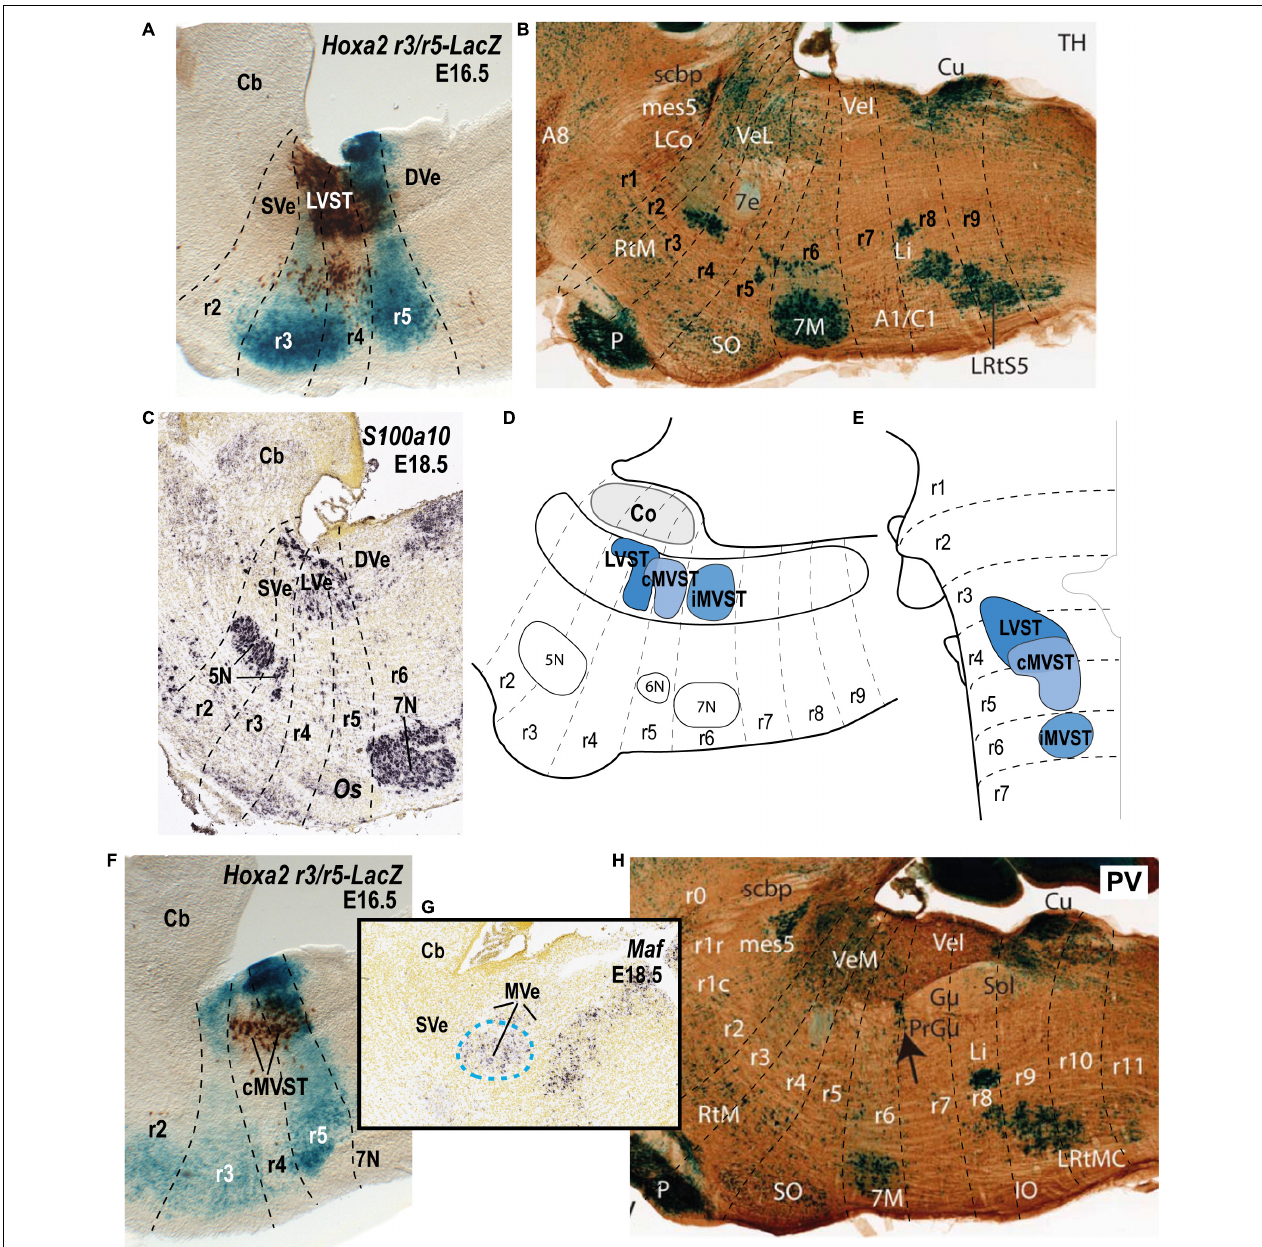
FIGURE 4 | Relationship of the vestibulospinal neuron groups to the rhombomeres in the mouse. (A) Lateral sagittal section illustrating retrograde biotin-conjugated dextran amine (BDA) labeling of the lateral vestibulospinal group (LVST) relative to the r3 and r5 domains in a r3/r5:lacZ transgenic mouse at E16.5 (see Pasqualetti et al., 2007). (B) Sagittal section of an adult AZIN1-lacZ mouse counterstained with antibodies to tyrosine hydroxylase (TH). Note the weak lacZ signal in the lateral vestibular nucleus (VeL), and the stronger lacZ signal in the mesencephalic trigeminal nucleus (mes5). Other recognizable characteristic landmarks are labeled [modified from Martinez-de-la-Torre et al. (2018); their Figure 1C ]. (C) S100a10 expression predominantly in the lateral vestibular nucleus (LVe; blue dashed line) in a sagittal section downloaded from the Allen Developing Mouse Brain Atlas (experiment 100055828; image 9 of 18). (D,E) Schematic comparison of the vestibulospinal neuron groups according to fate map reported by Pasqualetti et al. (2007). (F) Medial sagittal section showing retrograde BDA labeling of the contralateral medial vestibulospinal tract group (cMVST) in the r3/r5:lacZ transgenic mouse at E16.5 (Pasqualetti et al., 2007). (G) Expression of Maf at E18.5 (experiment 100132196; image 10 of 20: Allen Developing Mouse Brain Atlas). Note that Maf -positive cells in the rostralmost part of the medial vestibular nucleus (MVe, blue dashed line), have a location identical to that of the cMVST (compare to F) . (H) Sagittal section of an adult AZIN1-lacZ mouse counterstained with antibodies to parvalbumin (PV) showing lacZ expression in the medial vestibular nucleus (VeM). By contrast, the inferior (descending) vestibular nucleus (VeI) lacks lacZ signal [modified from Martinez-de-la-Torre et al. (2018); their Figure 2A ]. 5N, motor trigeminal nucleus; 6N, abducens nucleus;7N/7M, facial nucleus; Cb, cerebellum; Co, cochlear column; DVe/VeL, descending (inferior) vestibular nucleus; LVe/VeL, lateral vestibular nucleus; MVe/VeM, medial vestibular nucleus; Os/SO, superior olive; P, basilar pontine nuclei; r, rhombomere; SVe, superior vestibular nucleus.